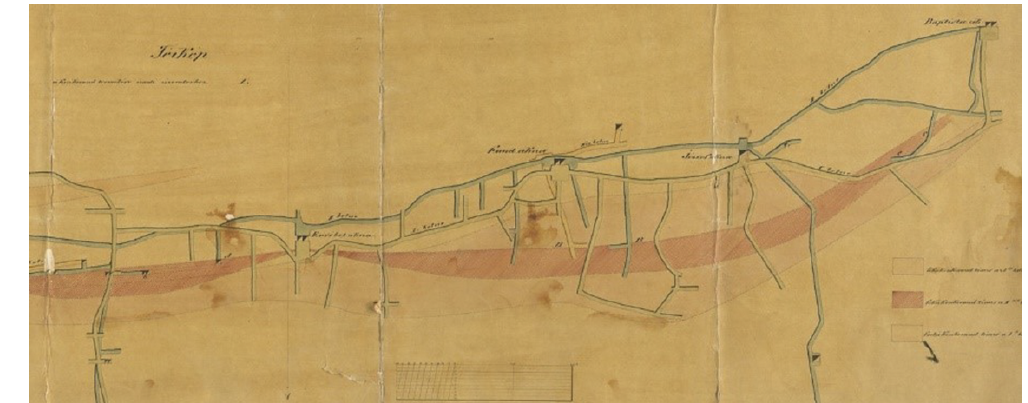
Figure 7. Mine map from the early 19th century showing the underground for cementation water mining in the mining field of Spitzen Berg hill (source: Slovak Mining Archive, Banská Štiavnica; the copy of the map was obtained in 2016b).